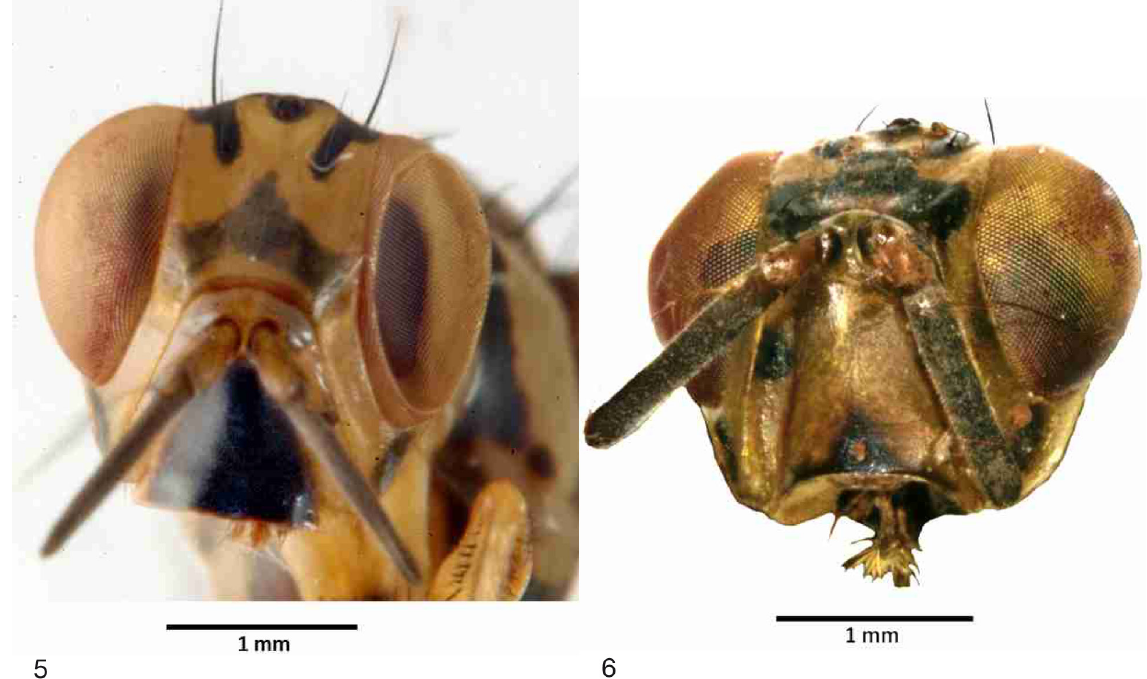
Figs 5–6. I. hancocki sp. nov., head, anterior view. 5 . ♂. 6 .